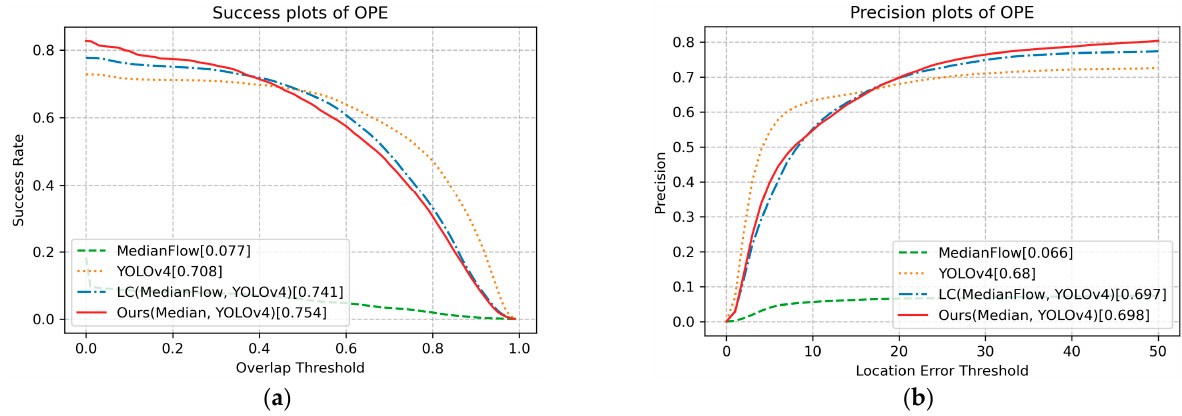
Figure 9. ( a ) Success plots on UAVL dataset; ( b ) precision plots on UAVL dataset.